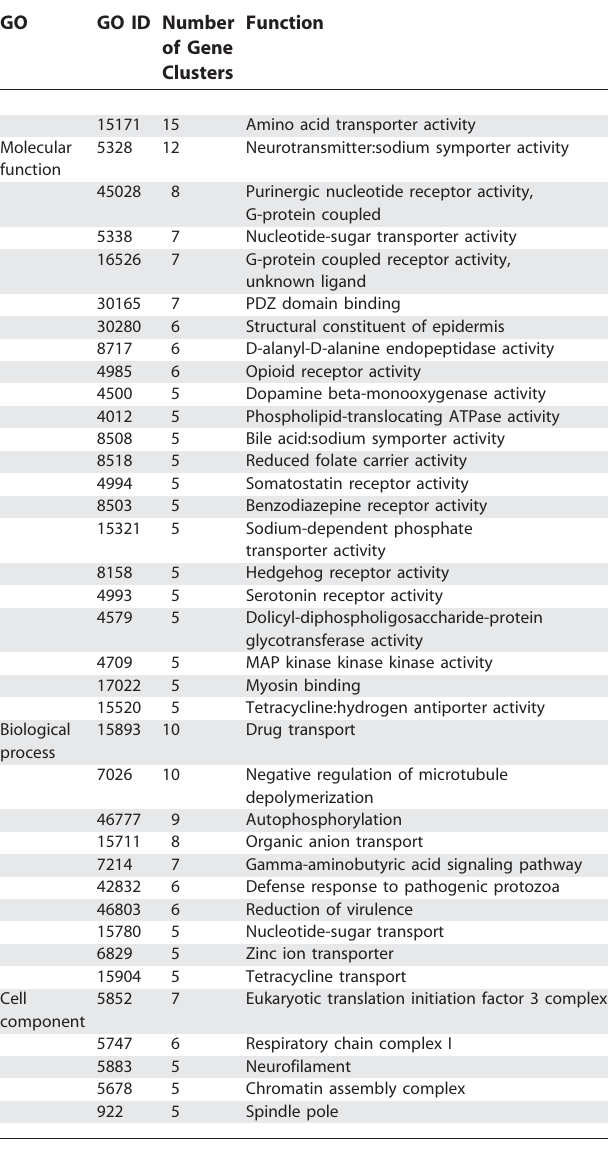
Table 6. Most Wanted Structures According to GO Classification